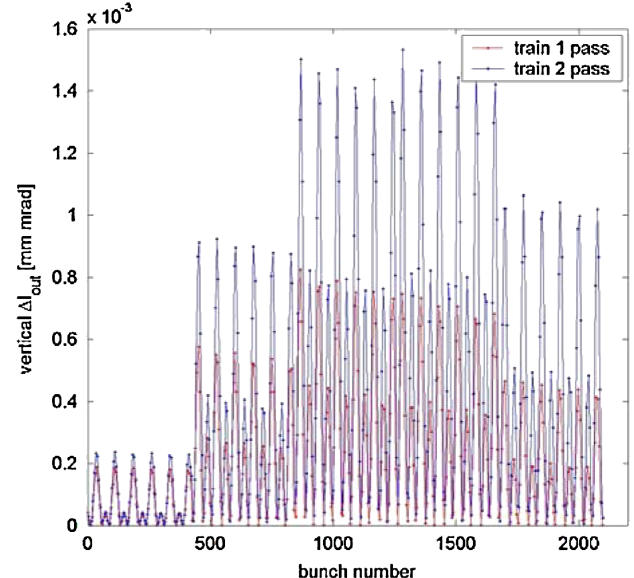
FIG. 21. (Color) Bunch centroids CSI calculated with respect to the case of no wake for a beam passing 1 mm off axis in the vertical plane.